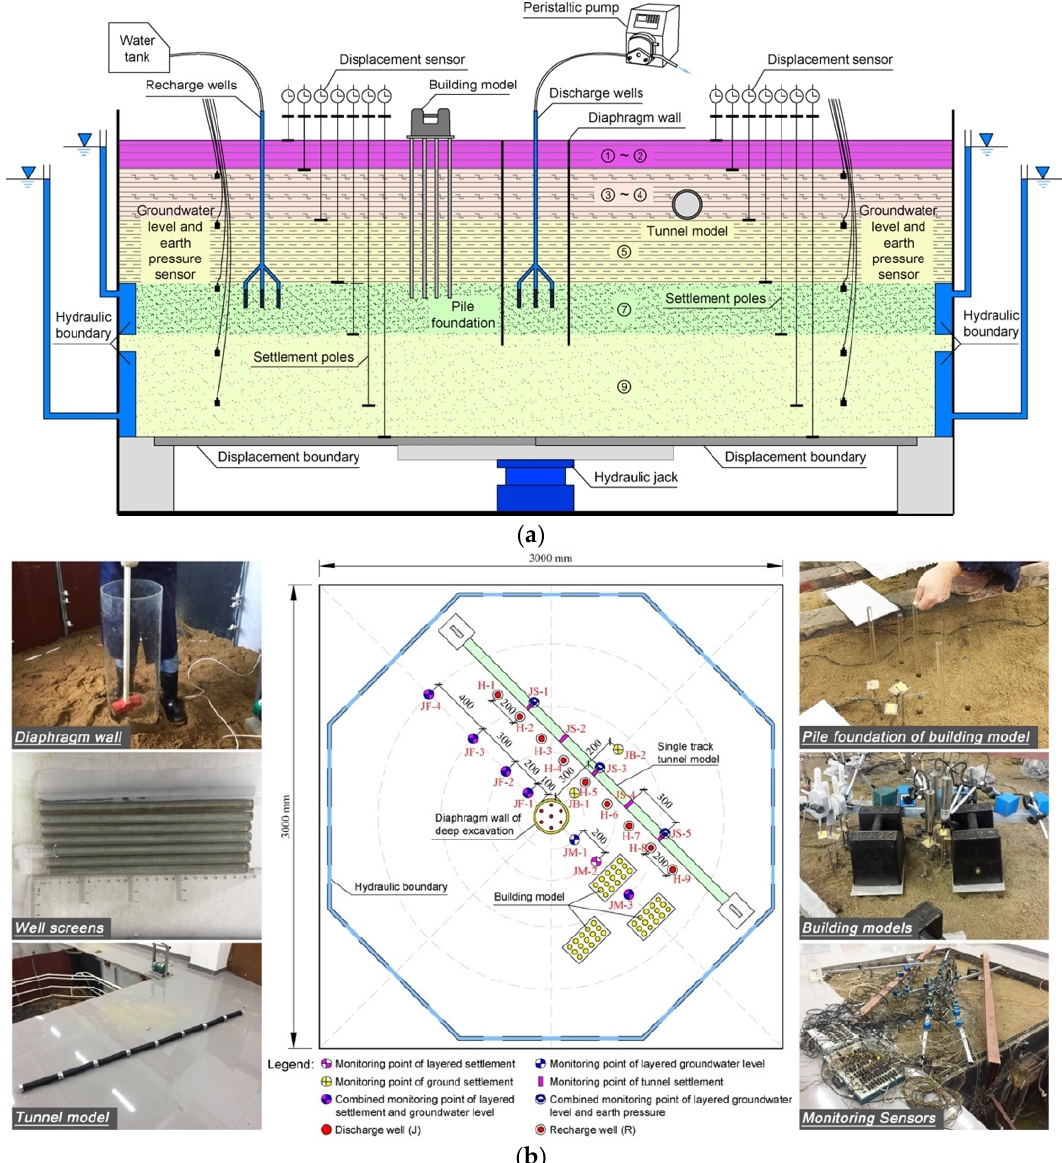
Figure 3. Layout of underground structure model and monitoring points: ( a ) Section view; ( b ) Plan view.